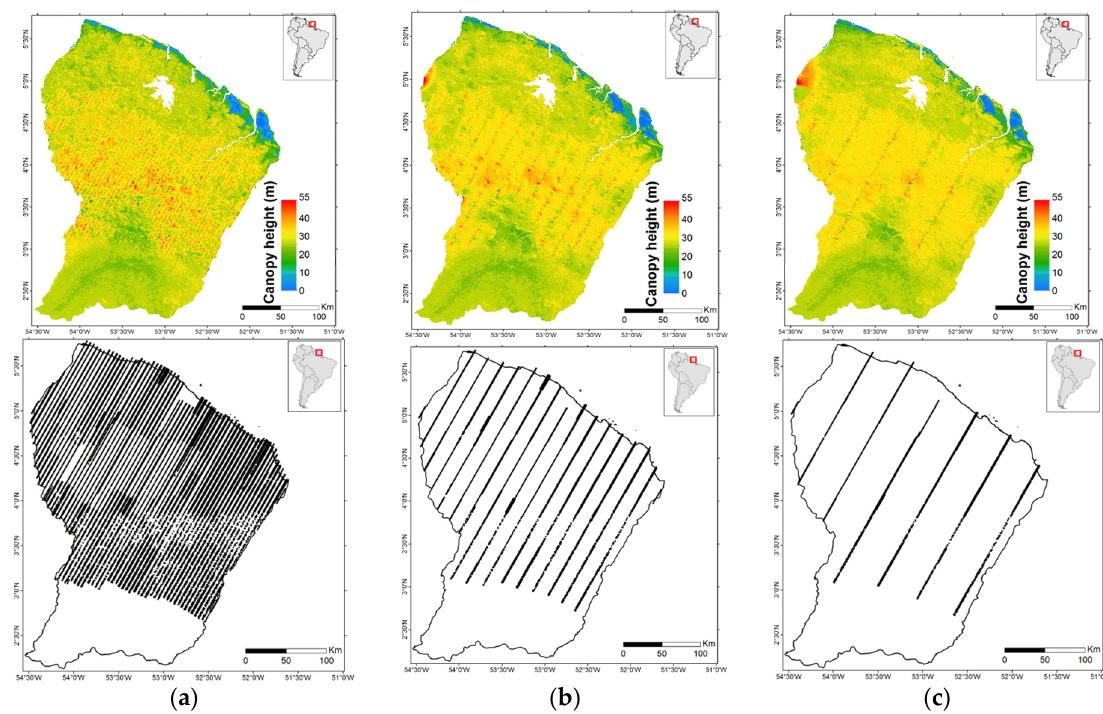
Figure 8. Examples of wall-to-wall maps of French Guiana with regression-kriging using as reference data the canopy height estimates from: ( a ) LD_5; ( b ) LD_20; and ( c ) LD_50.